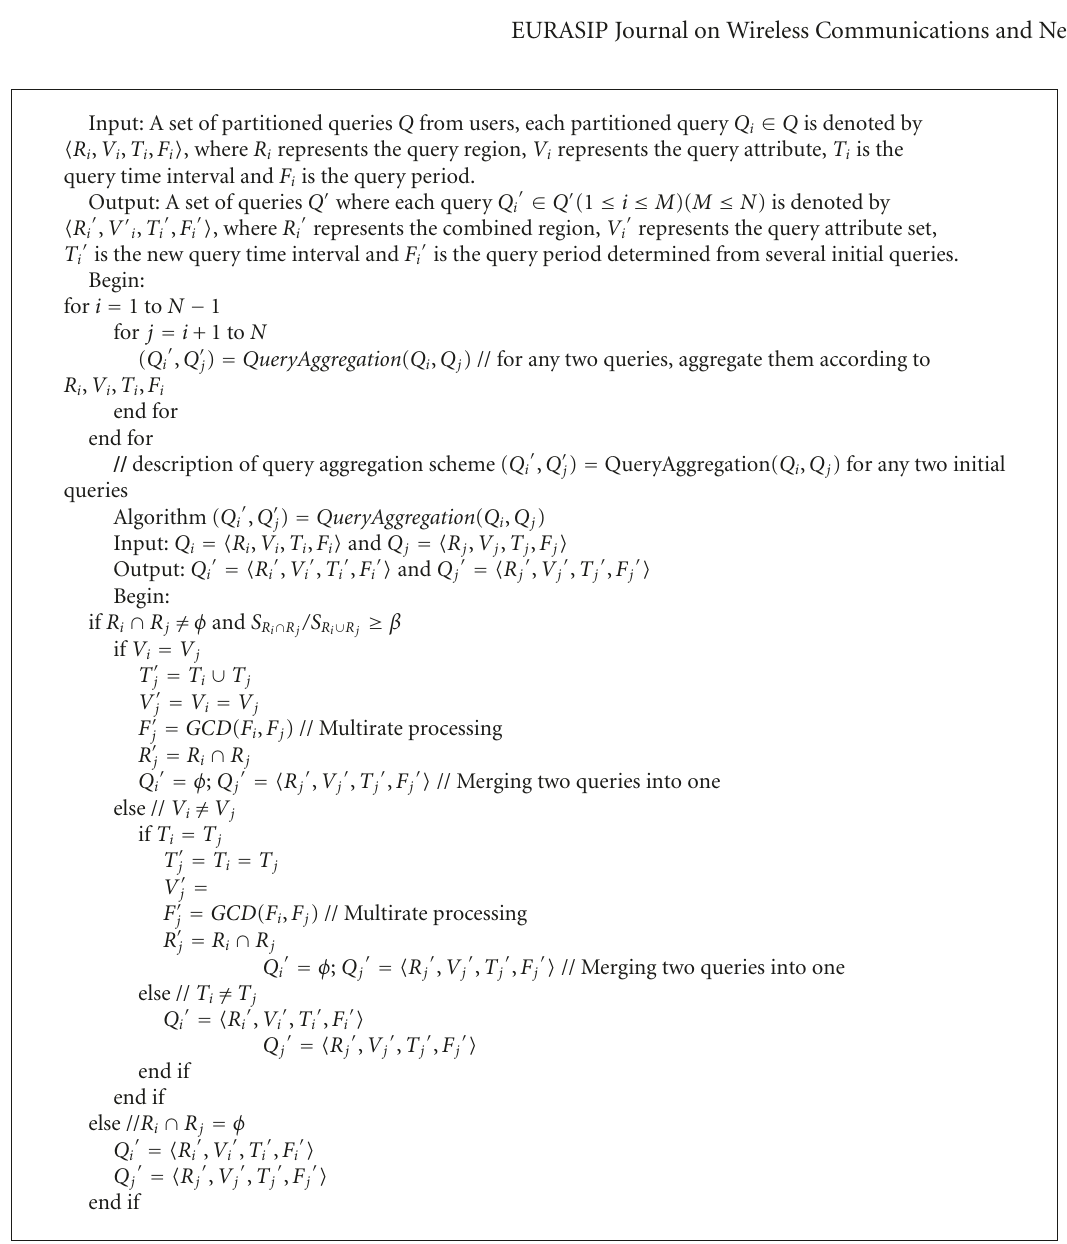
Algorithm 2: Query region, attribute, and time- and frequency-based query aggregation